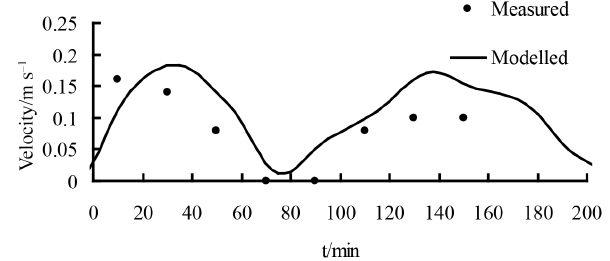
Figure 14. Comparisons of the measured and simulated velocities at location G1.